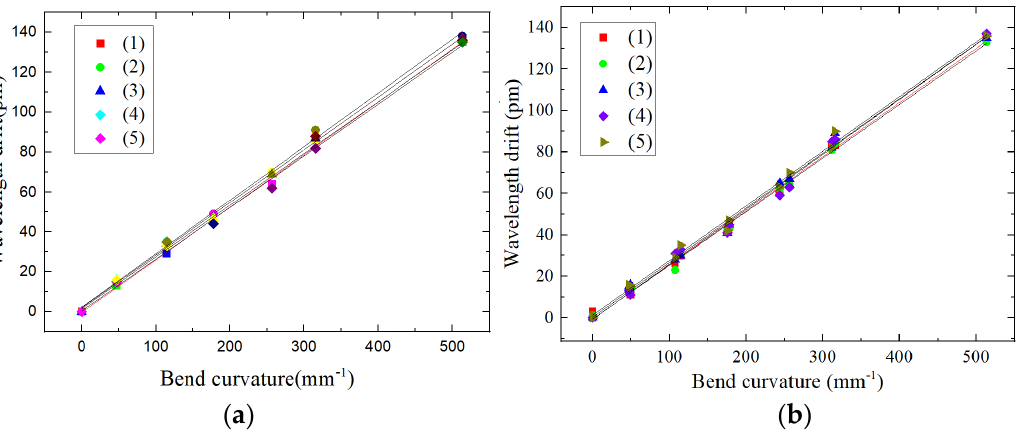
Figure 18. Shape sensor FBG hysteresis error analysis: ( a ) FBG1 center wavelength drift in forward-reverse stroke, ( b ) FBG2 center wavelength drift in forward-reverse stroke.